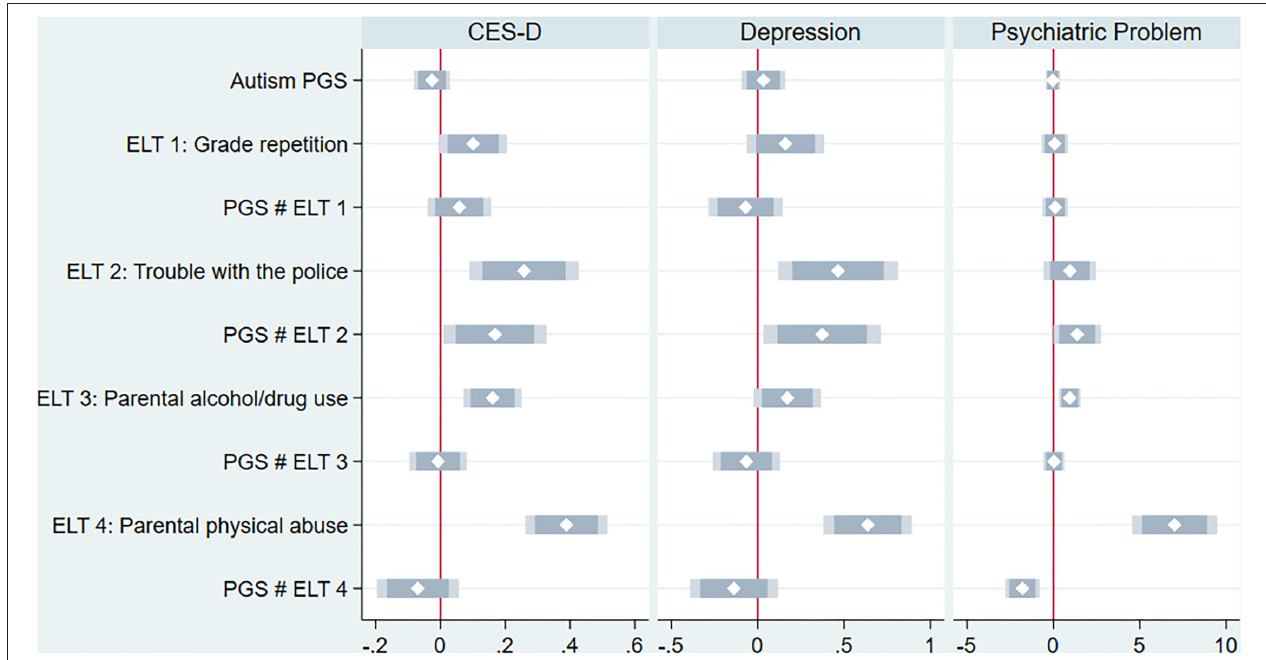
FIGURE 1 | Early life trauma as a moderator between autism PGS and mental